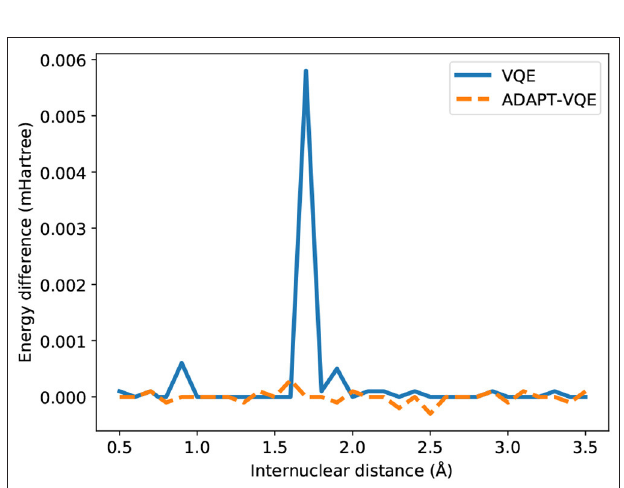
FIGURE 4 | Difference between the energies from COBYLA and L-BFGS optimization with central finite differences for the H 2 potential energy